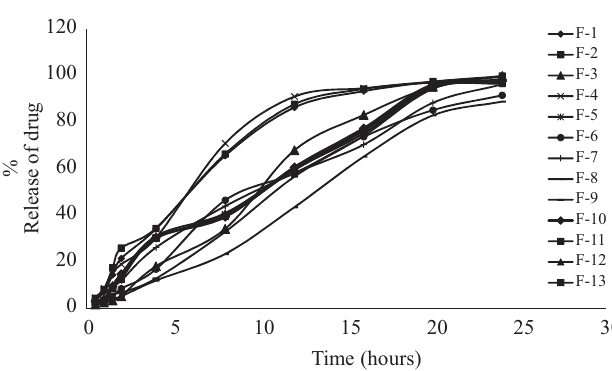
FIGURE 4 - In vitro drug release profile of flurbiprofen from directly compressed mucoadhesive tablets containing CP and